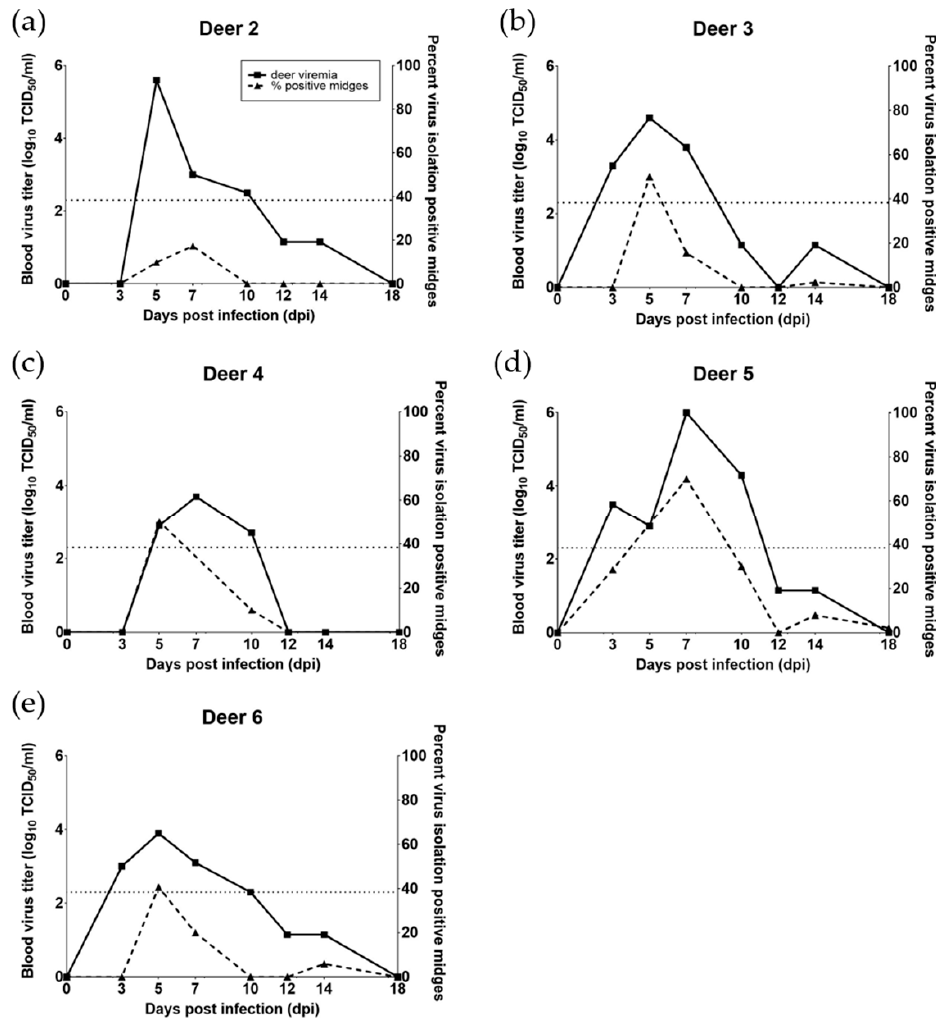
Figure 1. Viremia profiles spanning from 0 days post infection (dpi) to 18 dpi are plotted alongside midge infection prevalence for individual deer in the trial ( a – e ). A dotted line at 2.3 on the primary y-axis of each graph indicates the limit of detection for viral titer. Midge infection data for deer 5, 5 dpi and deer 4, 7 dpi have been omitted from their respective graphs due to contamination of samples during virus